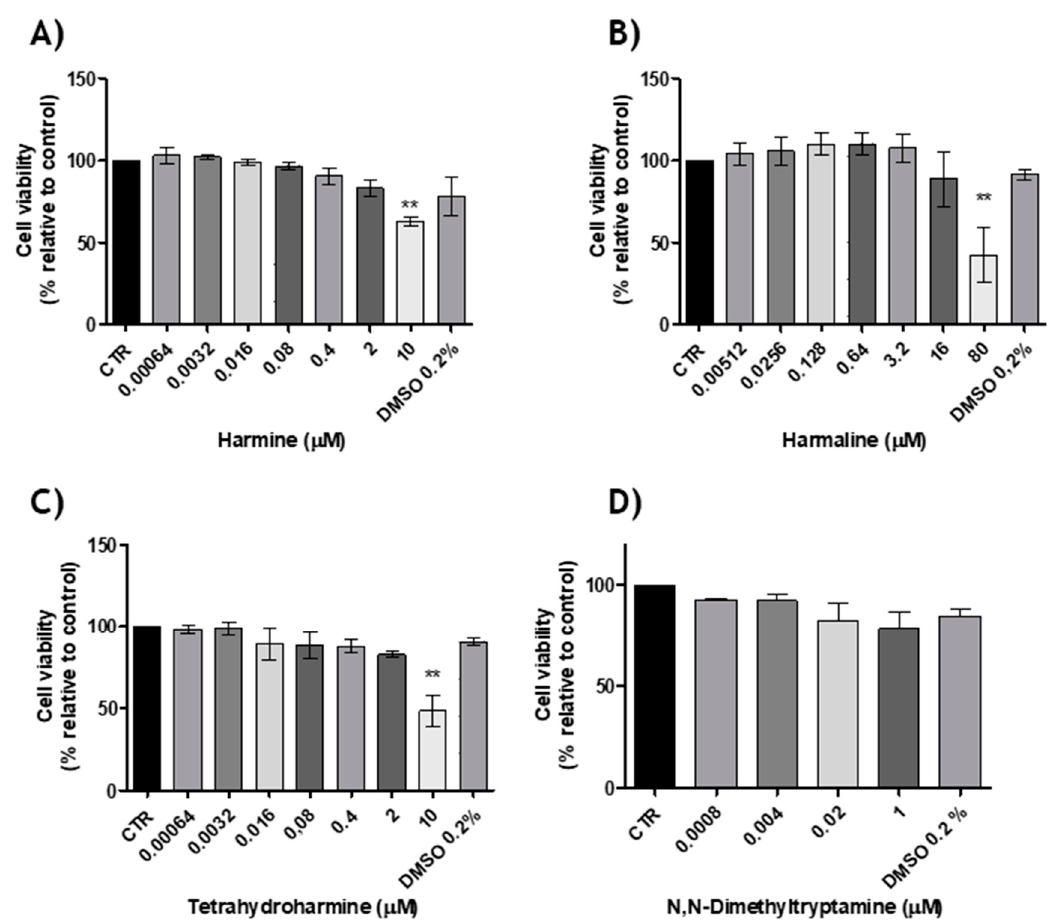
Figure 5. The effects of ( A ) HMN, ( B ) HML, ( C ) THH and ( D ) DMT on N27 cell line viability (24 h), ( n = 3, values are shown as mean ± SEM ** indicates values that are significantly different from control p < 0.01, one-way analysis of variance followed by Bonferroni’s multiple comparison test). CTR: Control.